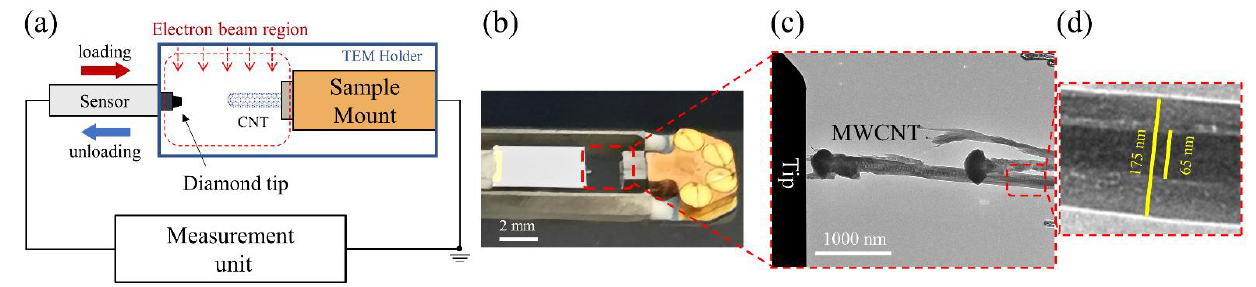
Figure 1. ( a ) Schematic illustration of the experimental setup for in situ TEM nanoindentation; ( b ) photograph of the TEM holder, showing the indenter facing the sample. The position of the indenter tip is controlled by the 3-axis movement of a piezo-motor; ( c ) a TEM image showing the initial position of the diamond tip and a single MWCNT in a compression experiment; ( d ) a magnified image of the CNT measuring the outer diameter of 175 nm and inner diameter of 65 nm, corresponding to 161 walls.